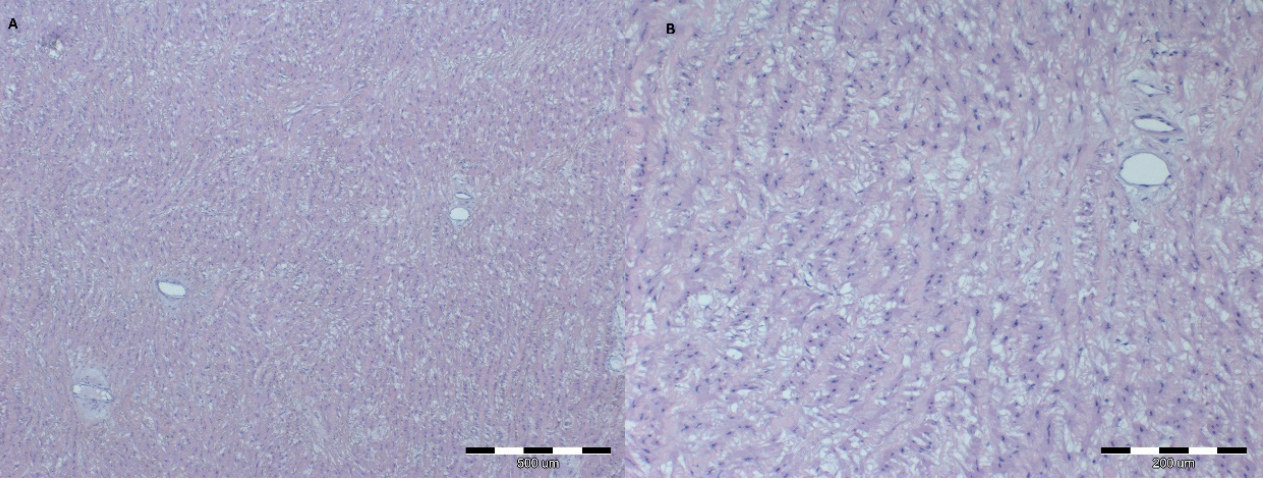
Figure 5. Microscopic image of the aorta specimen from an extremely obese horse. Aortic wall: re- laxation of the fiber system, structure disturbance, cell vacuolization; HE staining, 40× ( A ), 100× ( B ).